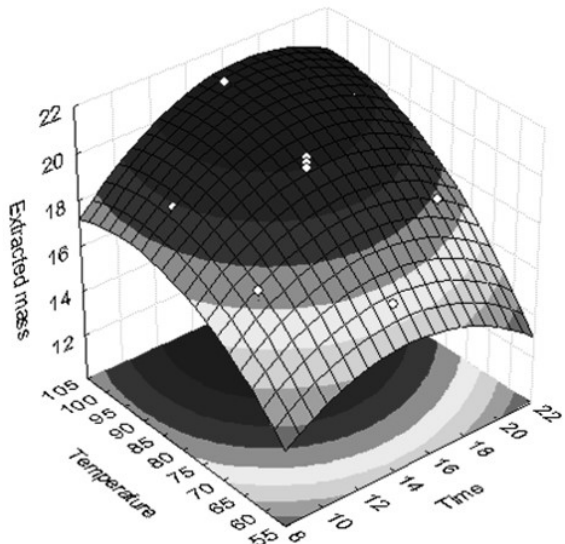
Figure 2. Response surface for Infusion time x Water